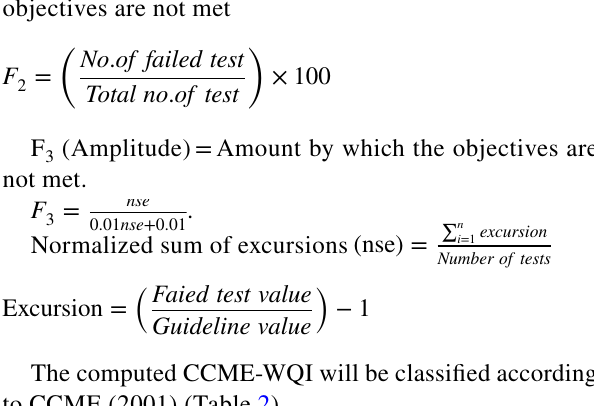
Table 2 Water quality scale for different indices